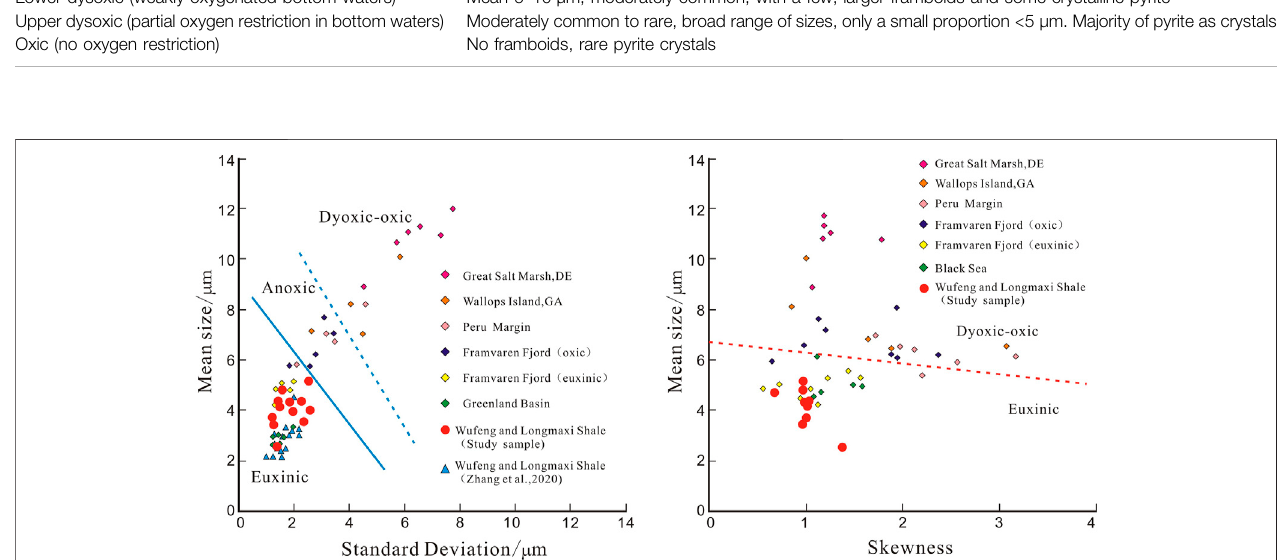
FIGURE6| Plot ofthemean vs. thestandard deviation (after Zhouet al., 2017;Zhanget al., 2020) and themean vs. theskewness oftheframboid sizedistribution (after Zhou et al., 2017).